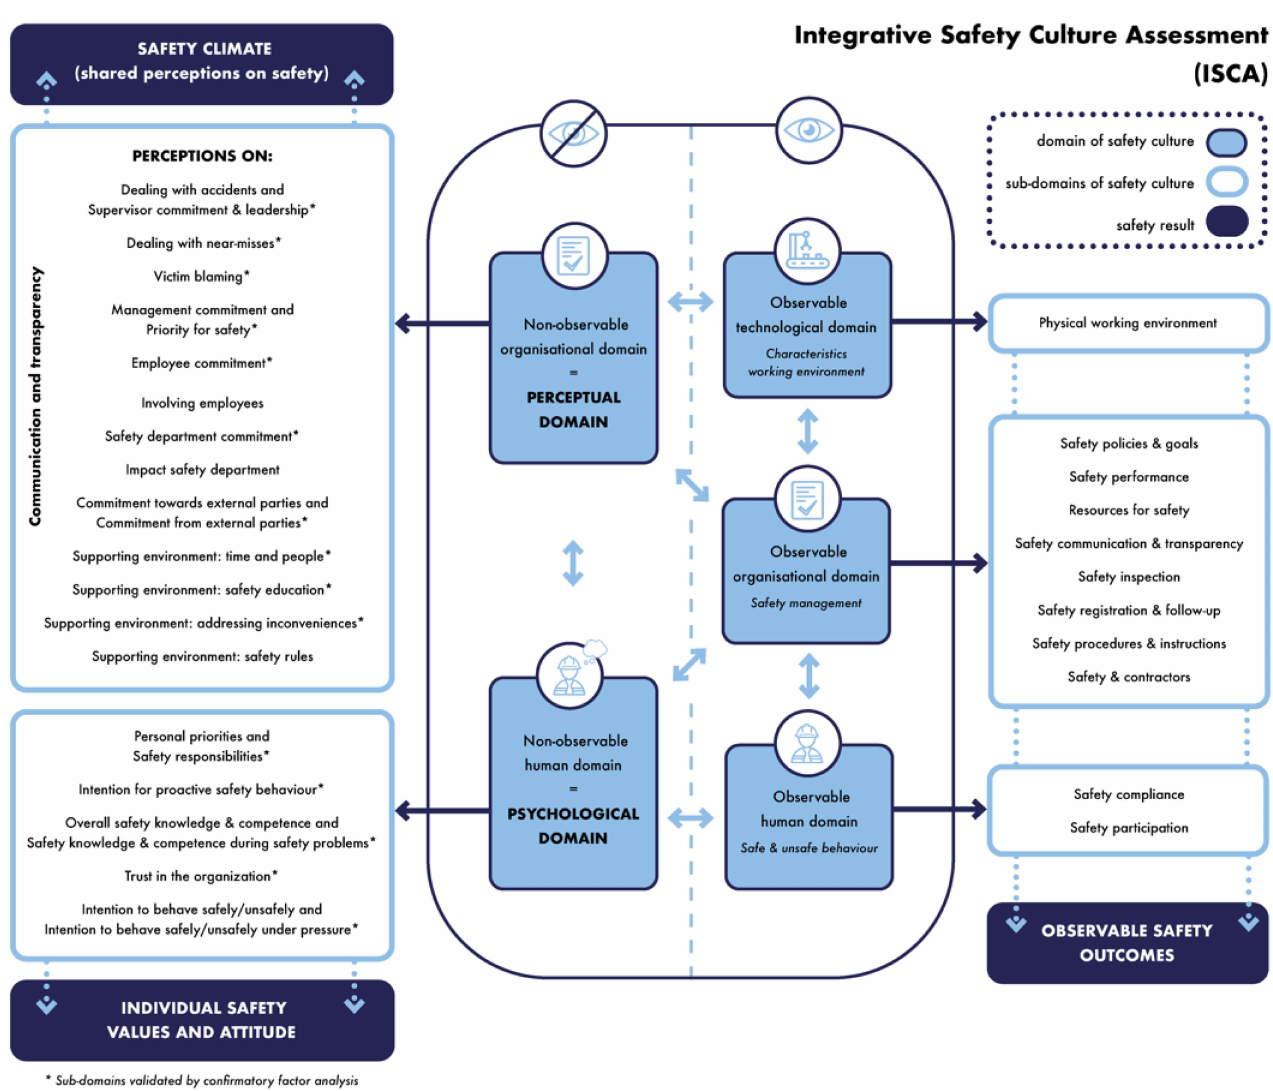
Figure 2. Integrative Safety Culture Assessment